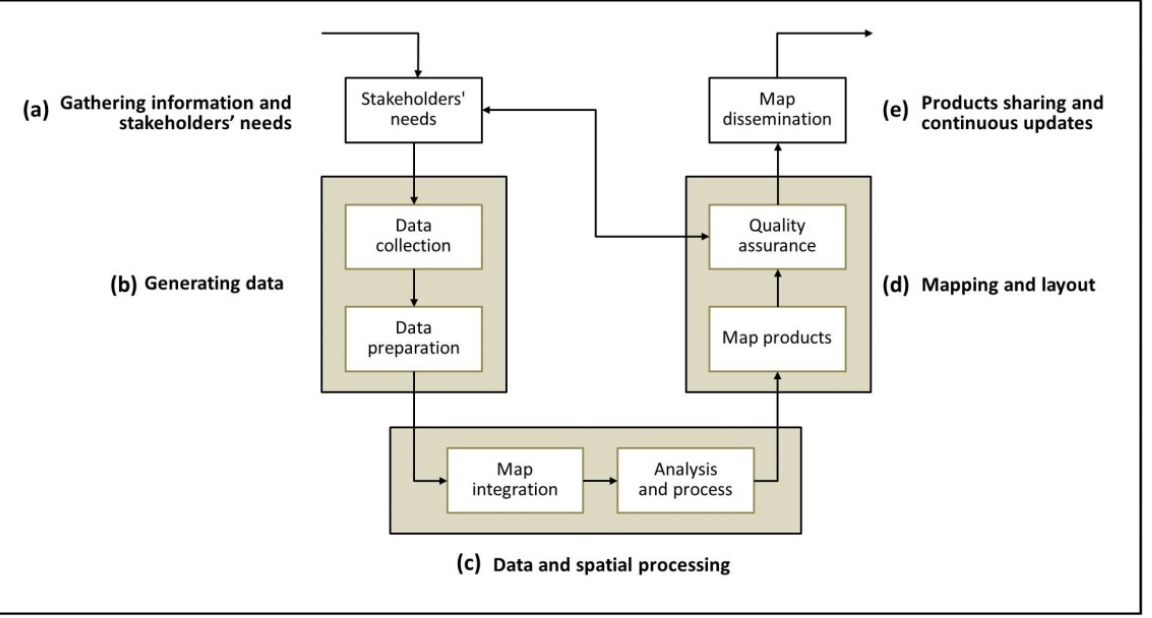
Figure 1. General workflow for EMT operations (adapted from [12]).